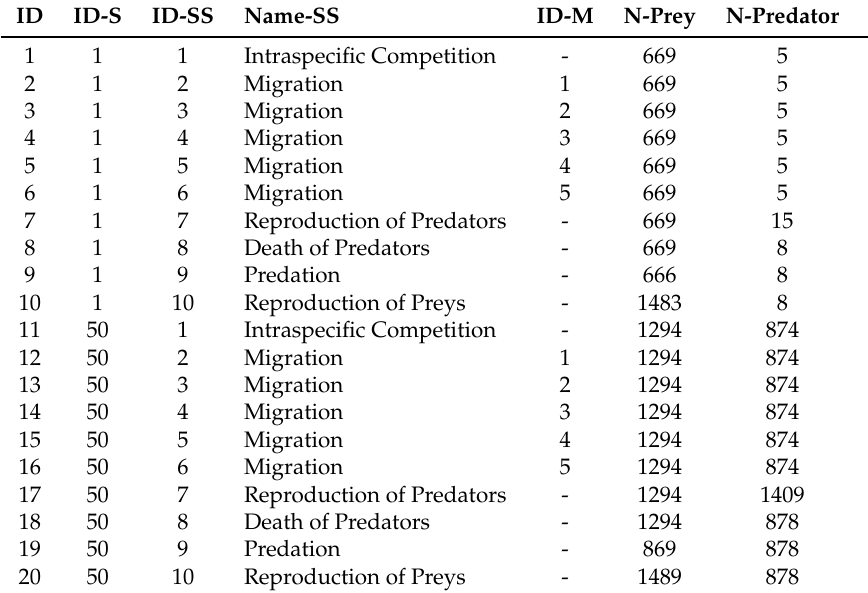
Table 10. Simulation performed using agents—Case B.